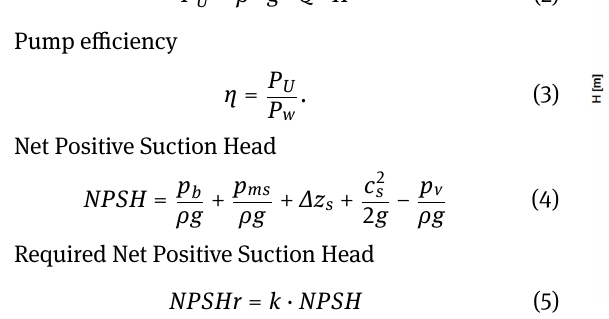
Figure 6: Cavitation curves of the Impeller 1